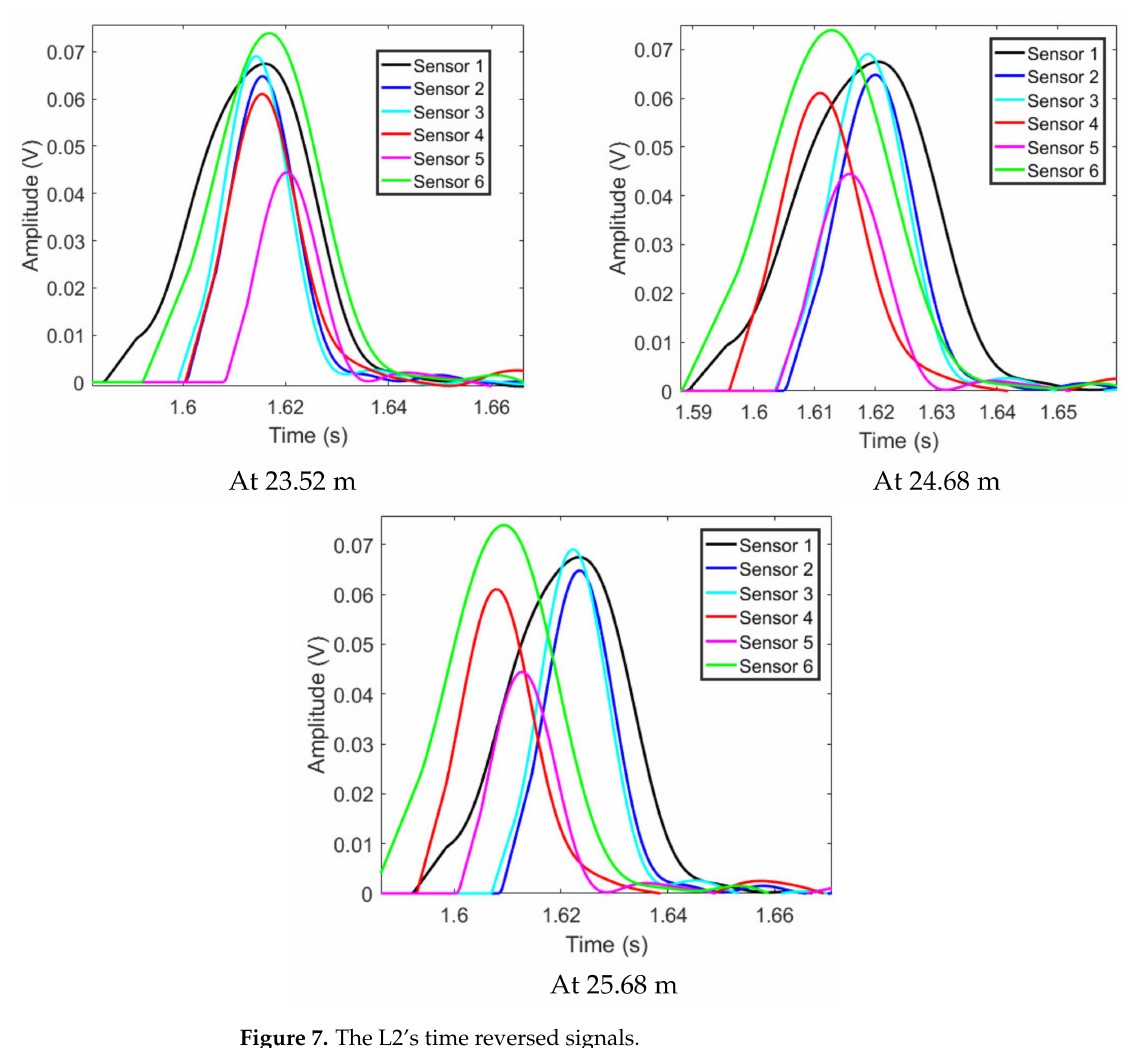
Figure 7. The L2’s time reversed signals.